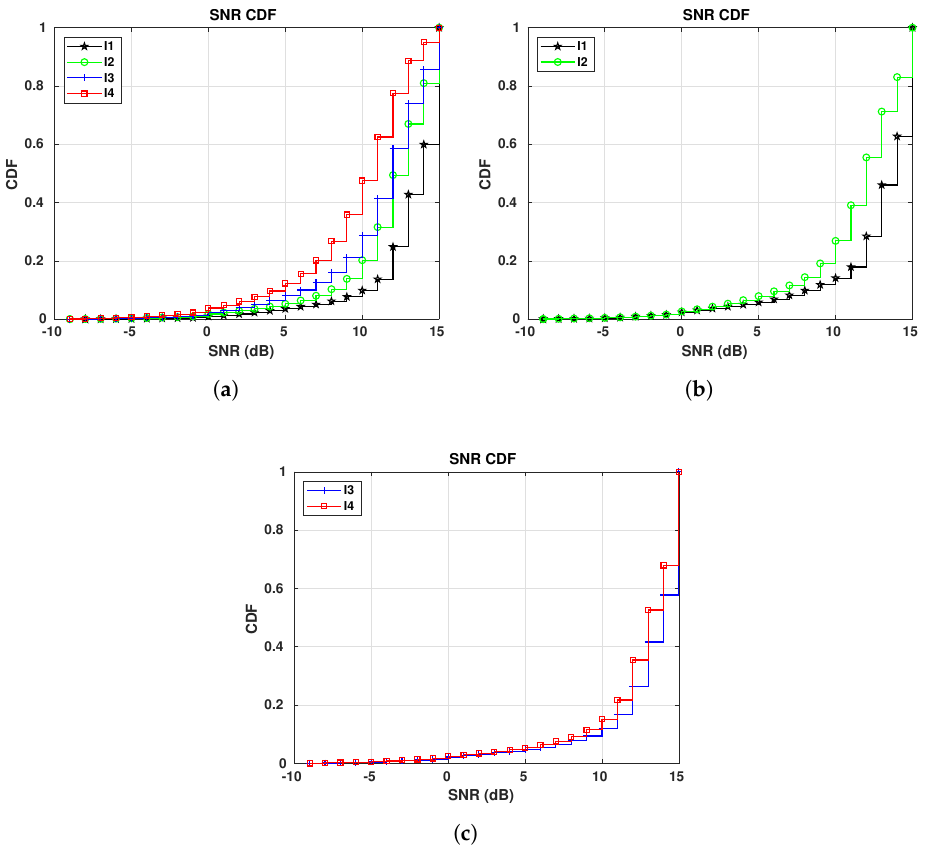
Figure 12. E1 SNR CDFs for all gateways in S1: I1 (16/01/2019 to 07/02/2019): − 16.96 ◦ C on average; I2 (22/12/2018 to 06/01/2019): − 9.45 ◦ C on average; I3 (25/10/2018 to 04/11/20018): − 0.15 ◦ C on average; I4 (30/09/2018 to 14/10/2018): 6.56 ◦ C on average. ( a ) E1 SNR CDFs for GW1. ( b ) E1 SNR CDFs for GW2. ( c ) E1 SNR CDFs for